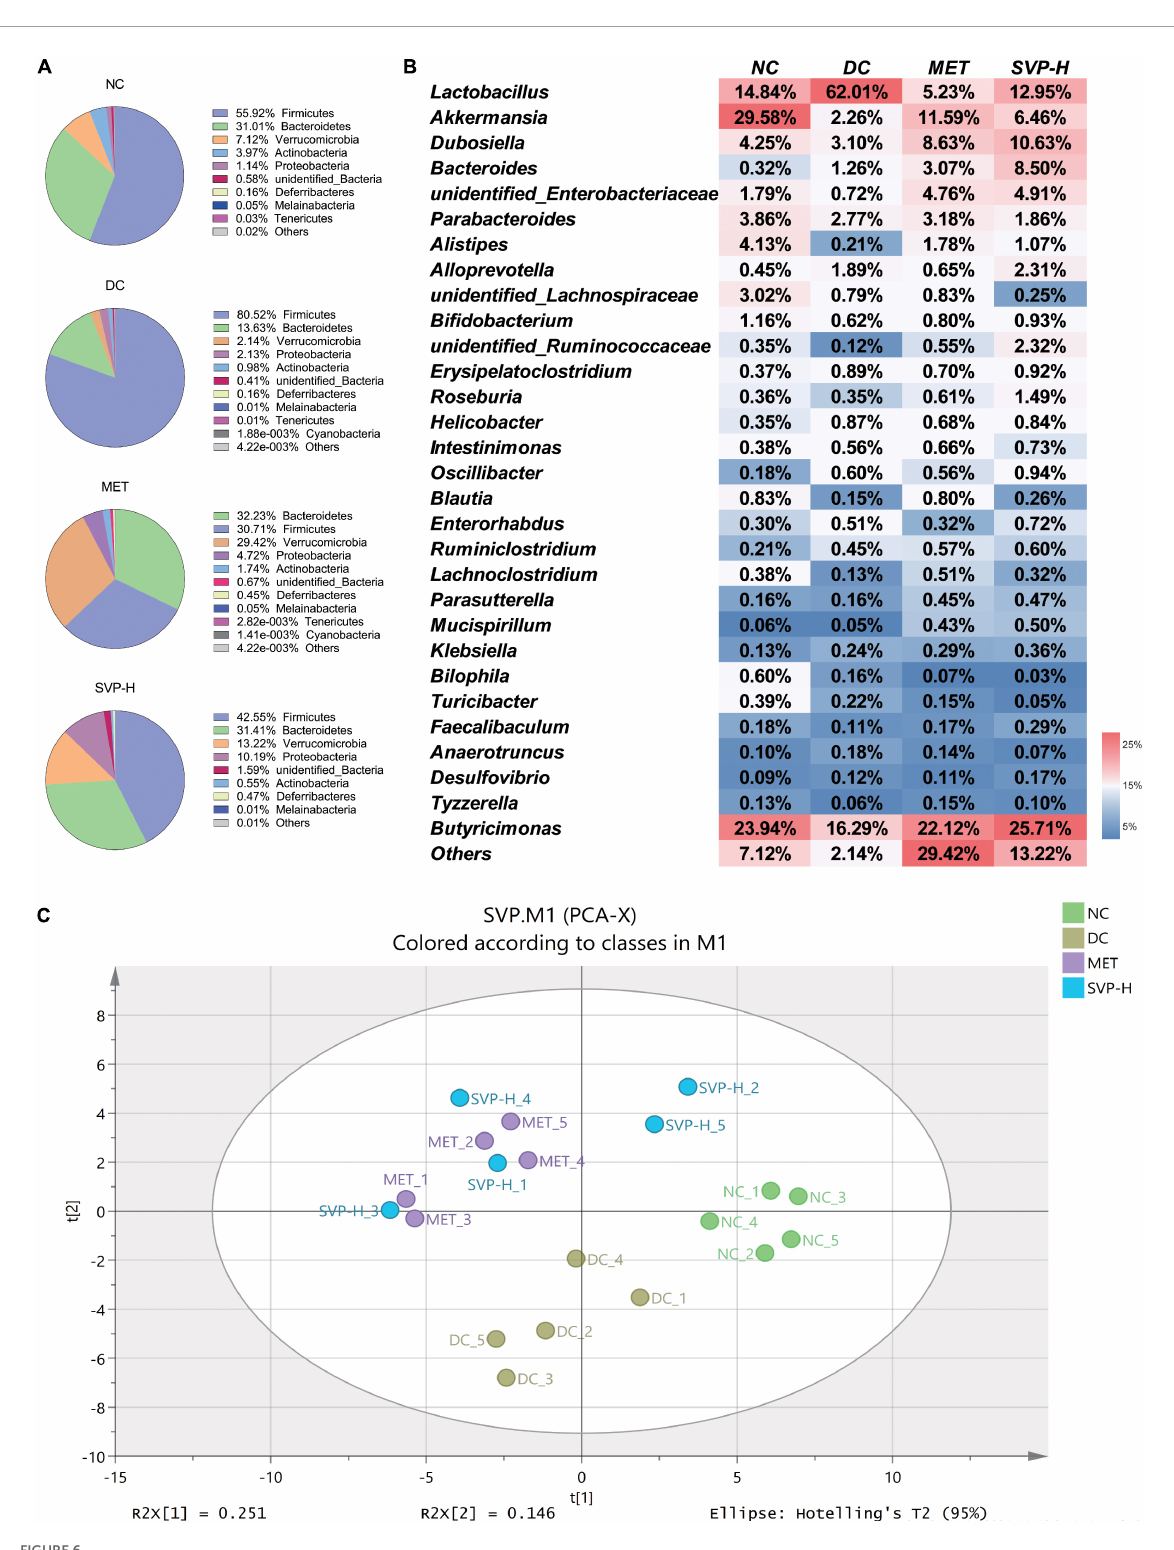
FIGURE6 Effects of oral SVP on the relative abundances and the structure of intestinal microbiota in T2DM mice. (A) Components of intestinal microbiota at phylum levels; (B) components of intestinal microbiota at genus levels; (C) principle component analysis score plot of intestinal microbiota at genus